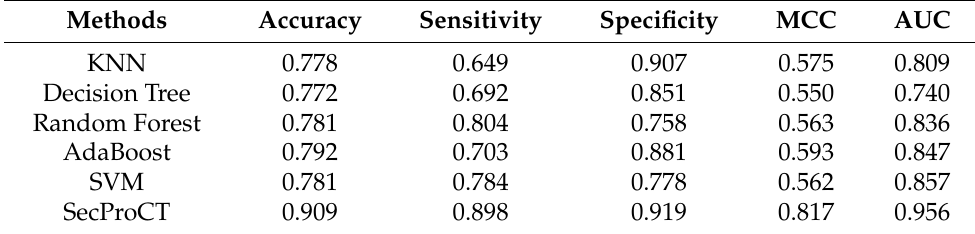
Table 3. Performance comparison with machine learning methods for predicting saliva-secretory proteins.